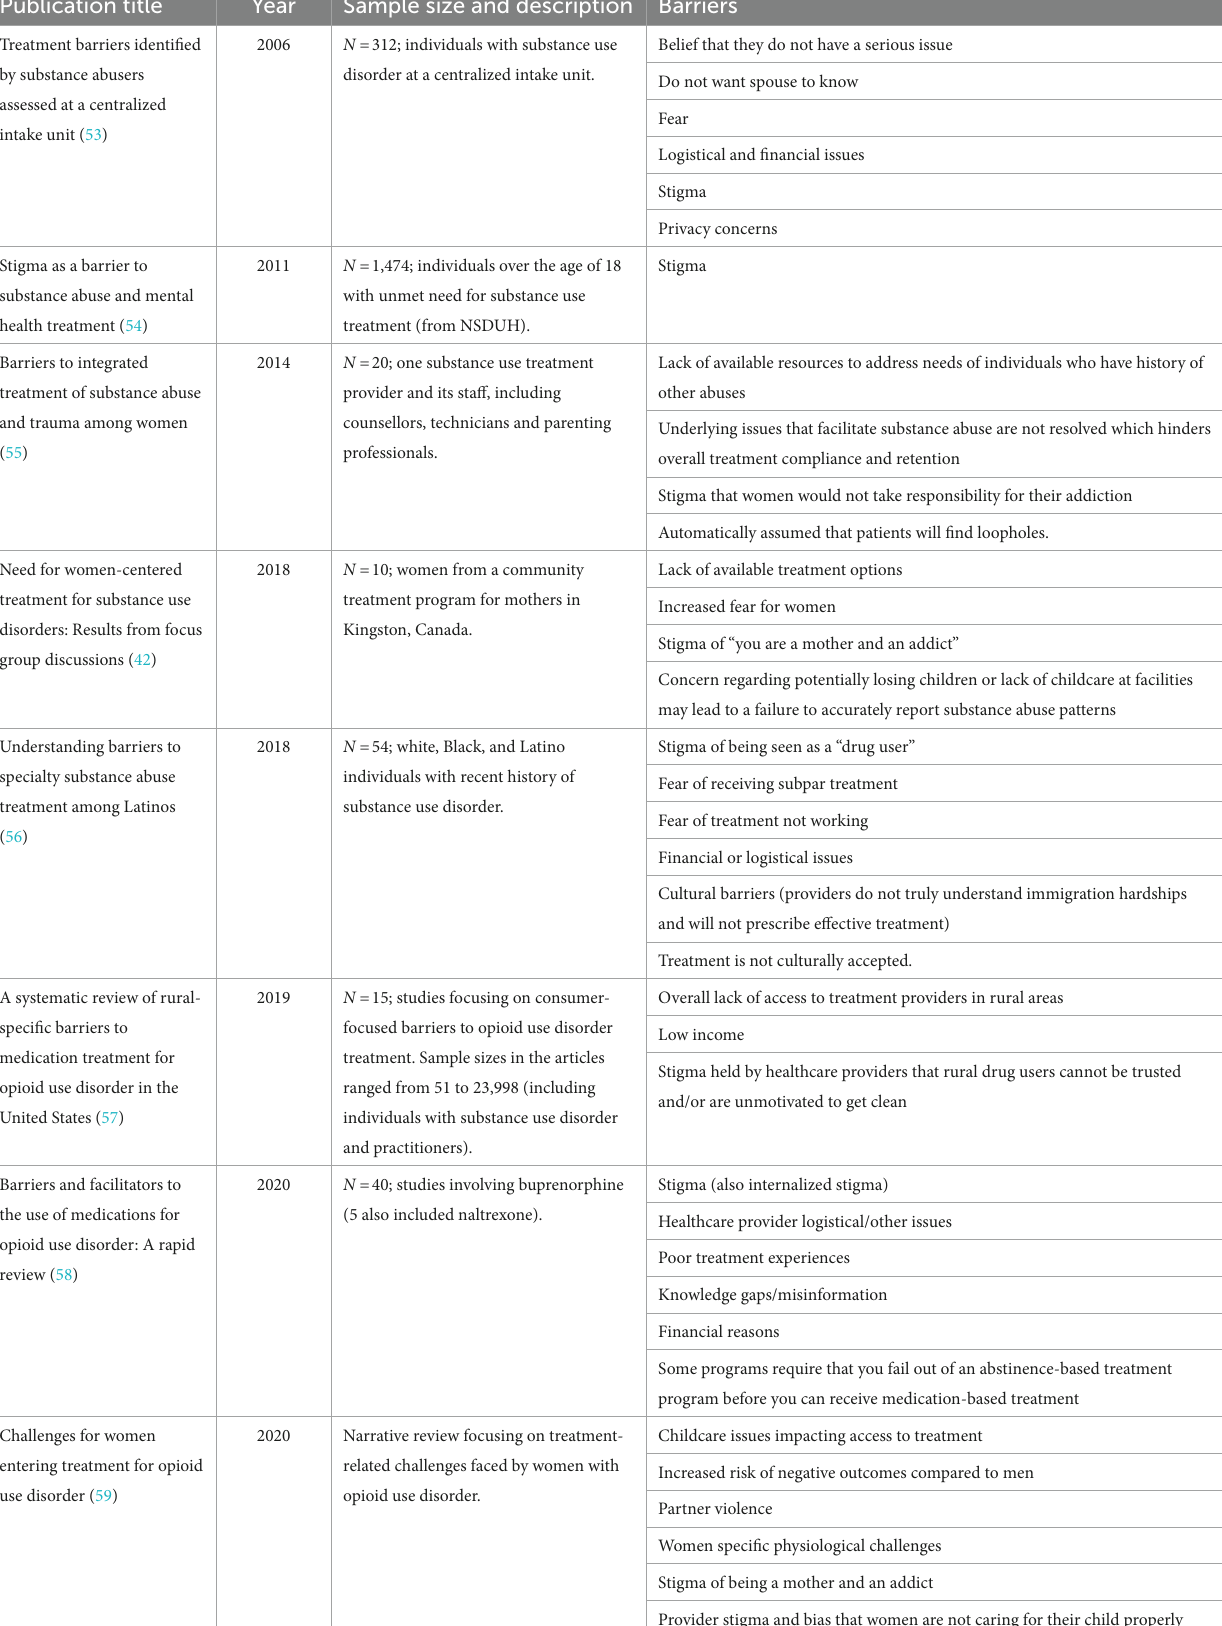
TABLE 1 Summary of barriers identified from the literature, the associated papers, and their years of